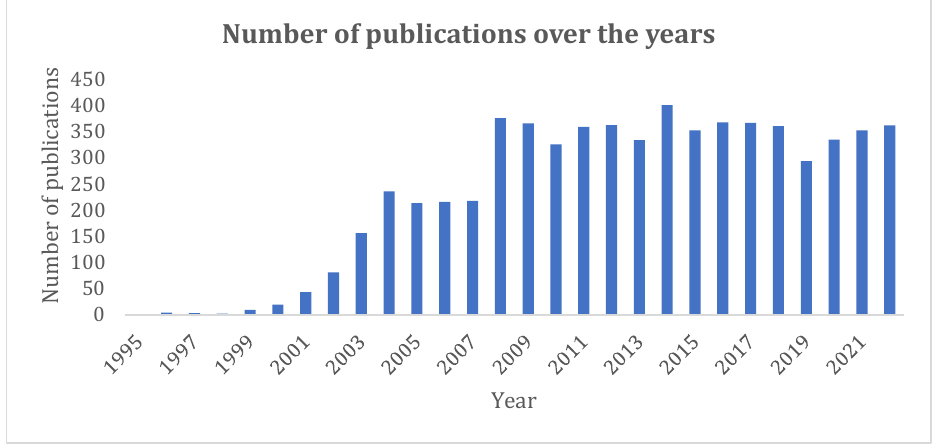
Figure 1. Graphical representation of publications per year in the domain of “ ionic liquids ” in “ catalysis ” in the period between 1995–2022. (Database: Scopus, search terms: “Ionic Liquids” AND “Catalysis”, January 2023).